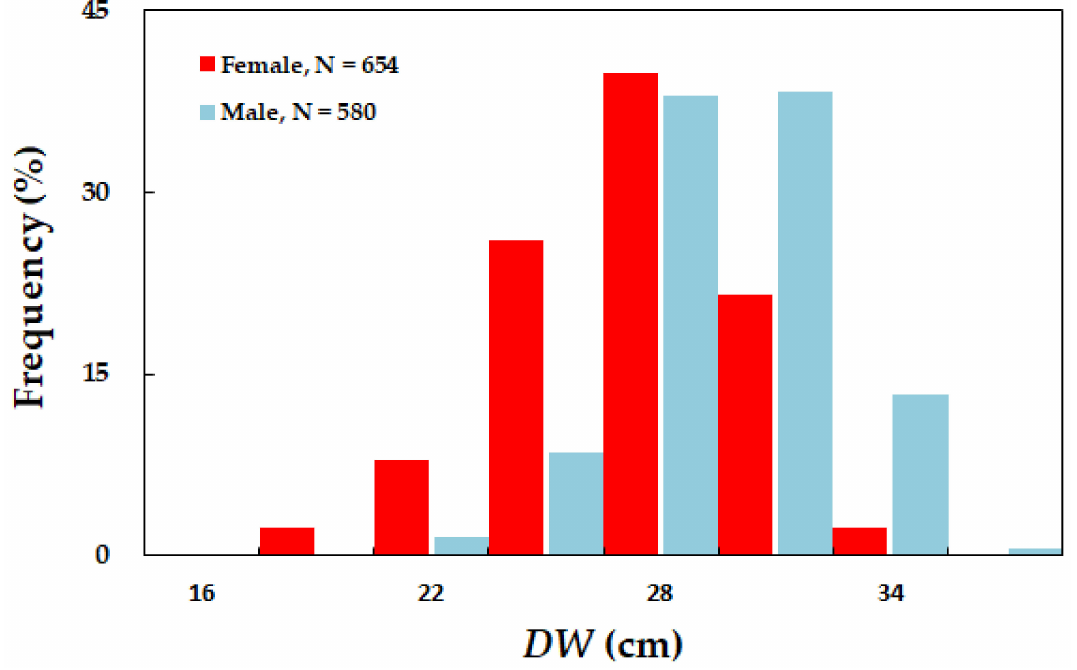
Figure 4. Frequency distribution of DW of ocellate spot skate Okamejei kenojei in the West Sea of